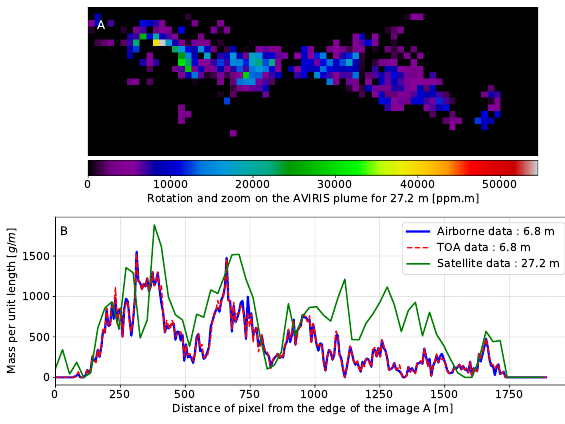
Figure 9. A : Concentration map zoom on the plume (in ppm.m) for TOA AVIRIS image with a spatial resolution of 27.2 m. B : Mass per unit length (in g/m) along the plume (in m) for different initial